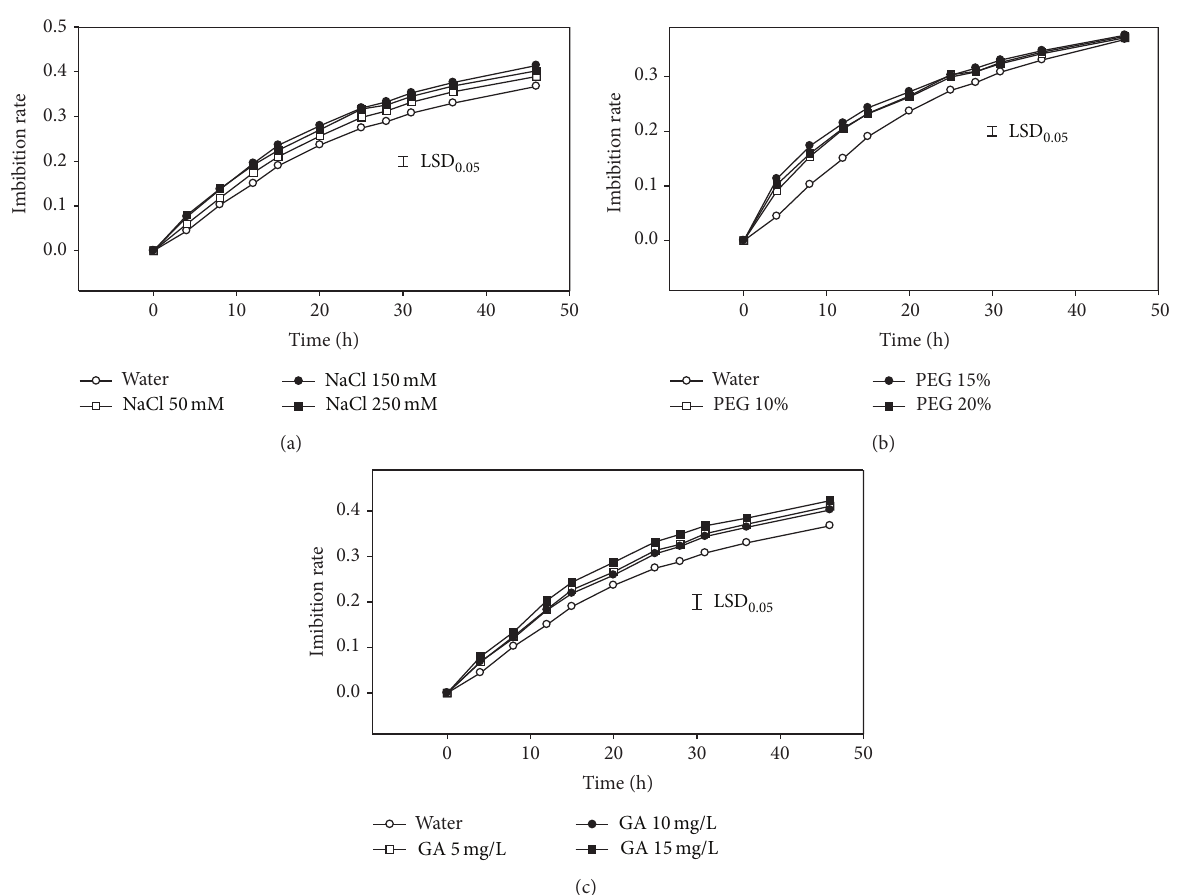
Figure 2: Effects of pretreatment reagents on imbibition rate after seed priming ( 𝑛 = 4 ).